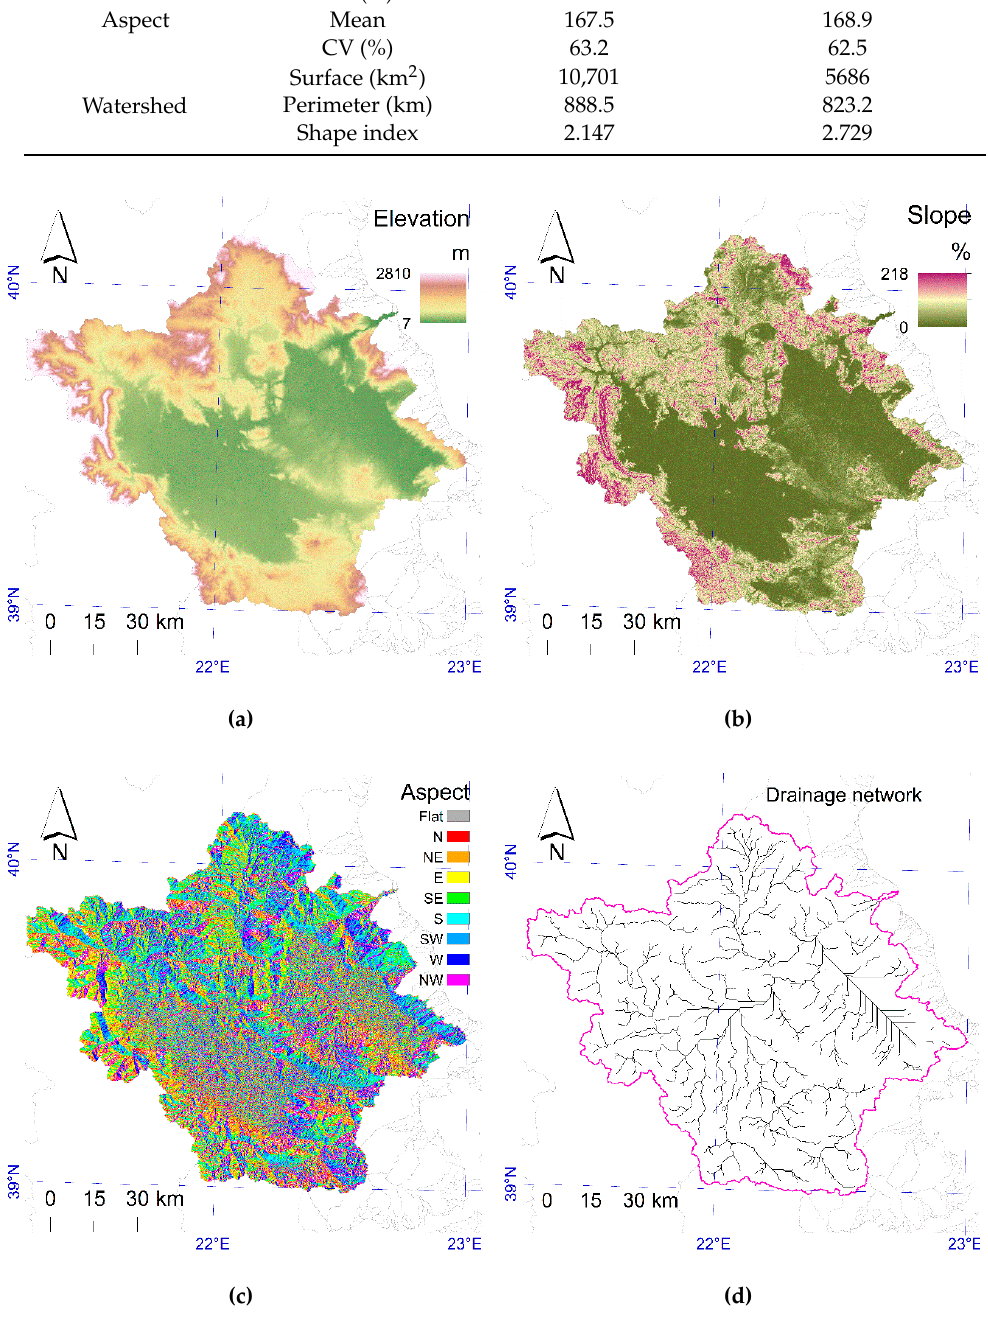
Figure 4. Topographic and hydrographic maps of the Pinios river basin: ( a ) elevation; ( b ) slope; ( c ) aspect; ( d ) drainage network (derived with flow accumulation thresholding (FAT)=10,000).